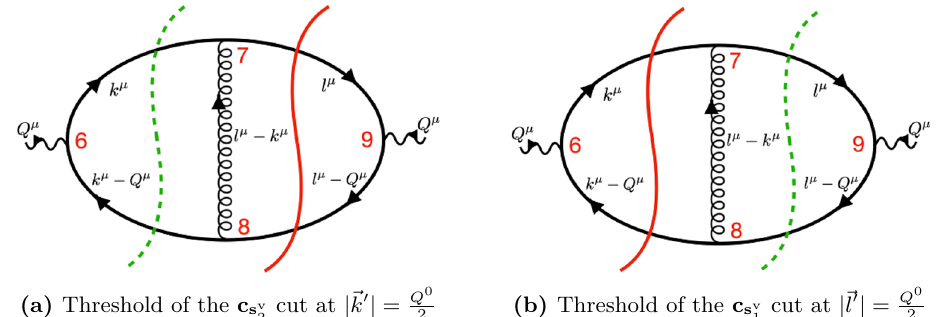
Figure 7. Pair of cancelling contributions from the E-surfaces (dashed green line) | ~k 0 | + | ~k 0 − ~Q | − Q 0 = 0 and | ~l 0 | + | ~l 0 − ~Q | − Q 0 = 0 of the Cutkosky cuts (solid red line) c s v When considering ~Q = ~ 0 , these two singularities are reached when x | ~k 0 | = | ~l 0 | because of the rescaling change of variables with t = t ? such point to t | ~k 0 | = t | ~l 0 | = Q 0